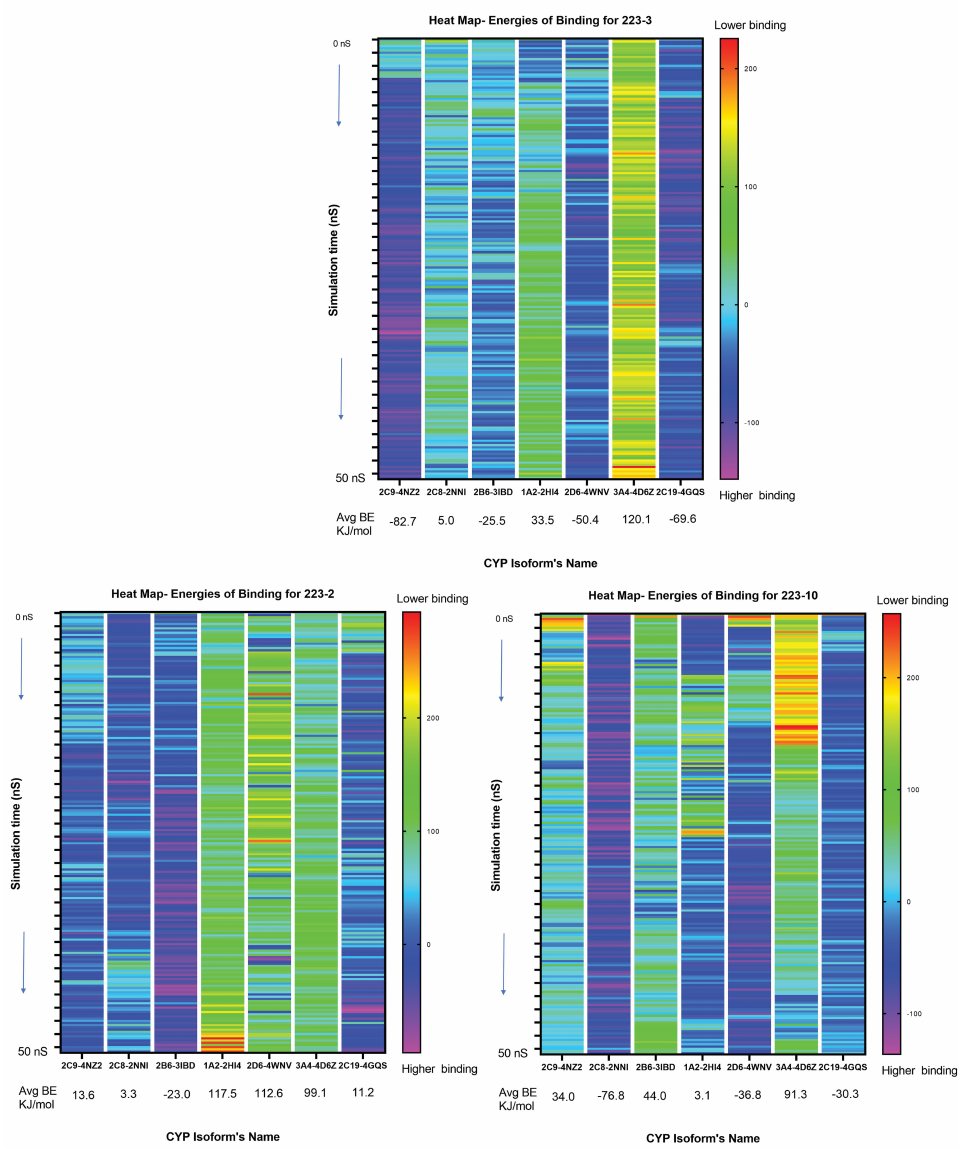
Figure 5. Binding energy of ligands is shown as a heat map calculated during the molecular dynamic (MD) simulation of 50 ns. The gradient of colored bands represents BE. The least binding is indicated by red bands, and the strongest binding by purple-colored bands. The greater the negative value of ∆ G, the better the stability of the ligand-CYP complex, and conversely, + ∆ G means an unstable − ligand-CYP complex. Based on the MD simulation, the binding of the ligands can be hypothesized as 223-3 > 223-10 > 223-2. Therefore, 223-2 is the least prominent